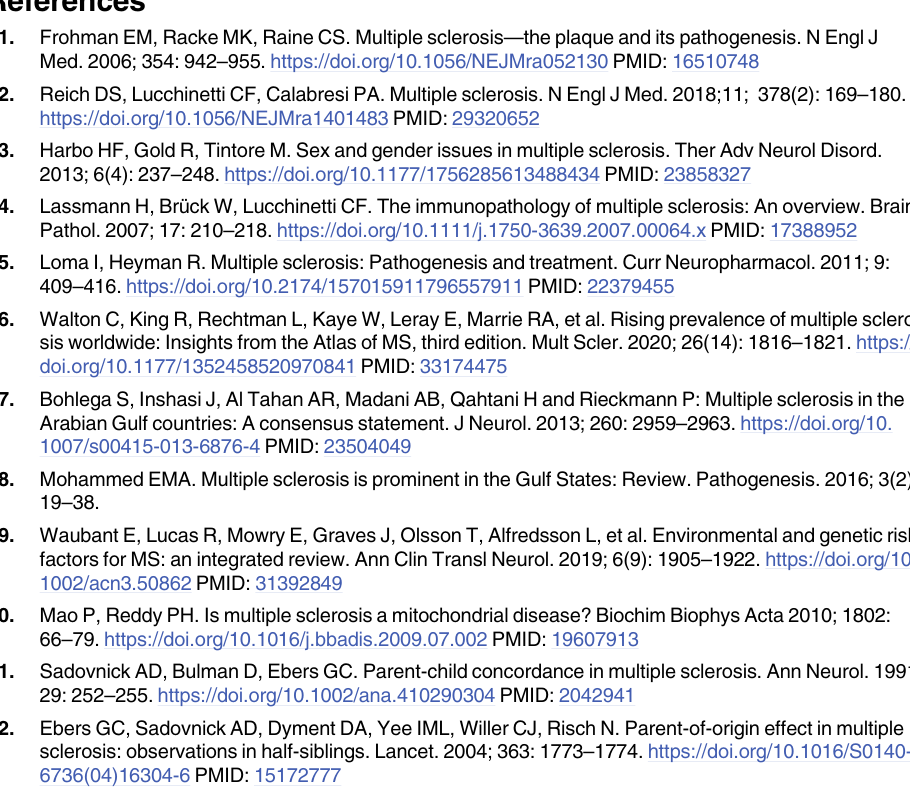
S3 Fig. Sequence alignment of MT-TL2 gene for tRNA Leu(CUN) in different species. Align- ment was retrieved from http://mamit-trna.u-strasbg.fr/. The arrow indicates the conservation of the A nucleotide throughout species (yellow highlight). The conservation index (CI) was 100% in all 16